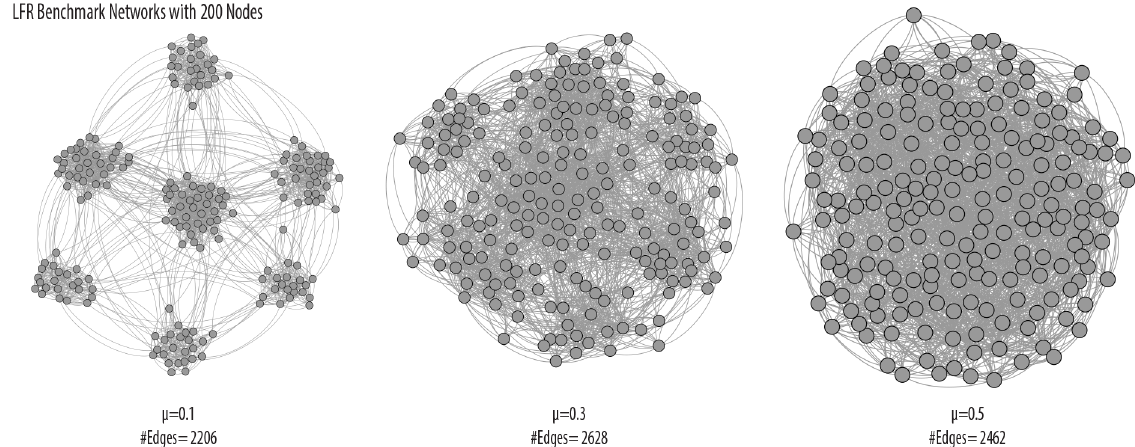
Fig 2. The impact of μ on cluster detectability, visualized using the spring-embedded “ ForceAtlas ” algorithm of the software Gephi [12].